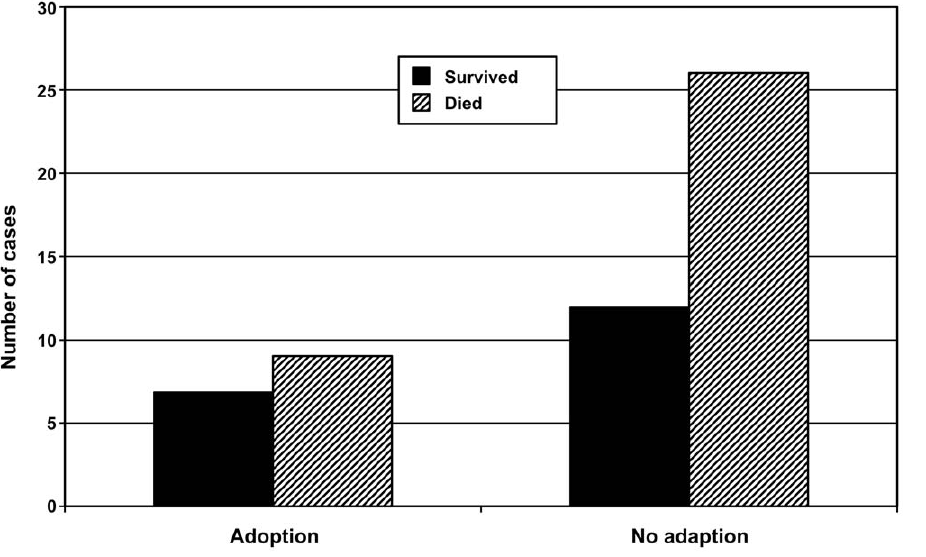
Figure 2. Orphans adopted do not present higher likelihood of surviving for 2 years the death of their mother than non-adopted orphans in Taı¨ chimpanzees (X2=0.37, df=1, p=0.54).